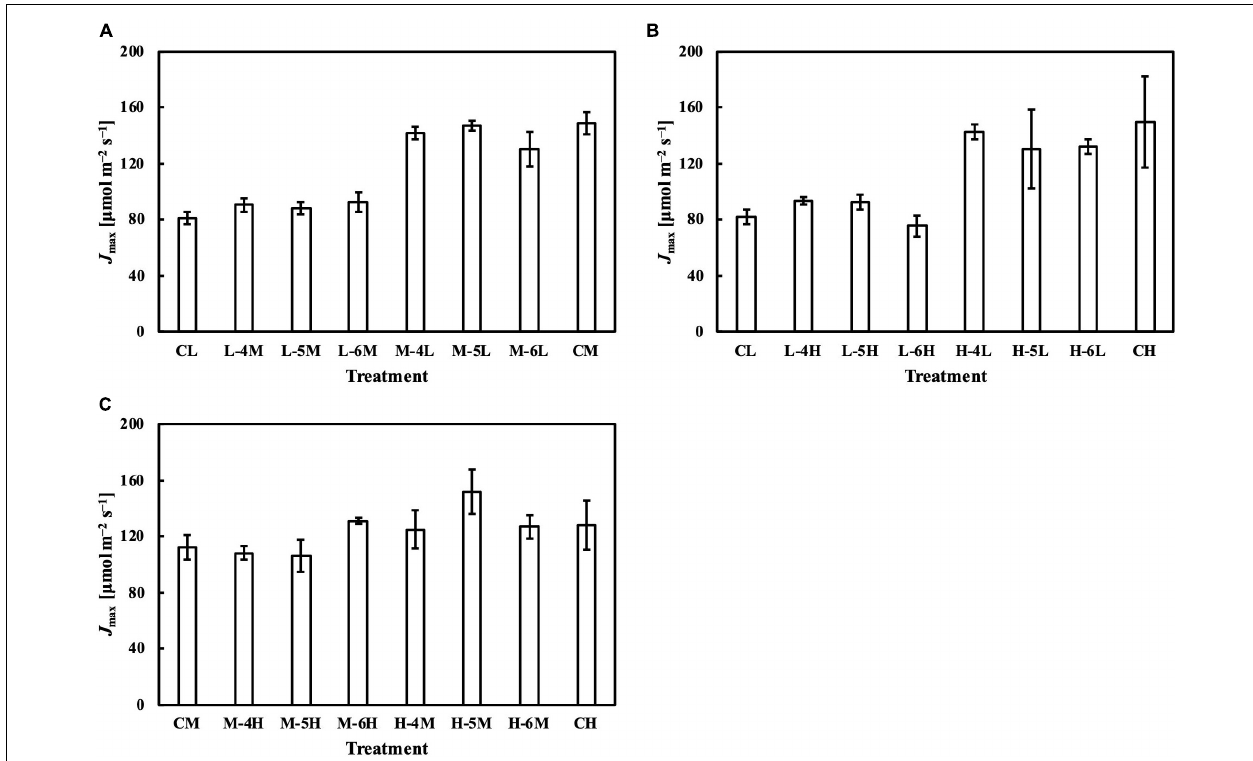
FIGURE 10 | J max of leaves subjected to a PPFD for 1 day different from the basal PPFD in the other days. CL and CM: treatments with a constant PPFD of 100 and 400 µ mol m − 2 s − 1 , respectively. The experiment was divided into three groups (A–C) and conducted separately due to limited experimental capacity. Values were means ± standard errors ( n = 3). L–4M: treatment with a PPFD of 400 µ mol m − 2 s − 1 in the fourth day of treatment period and a basal PPFD of 100 µ mol m − 2 s − 1 in the other 5 days. See Supplementary Table 2 for details of treatments.